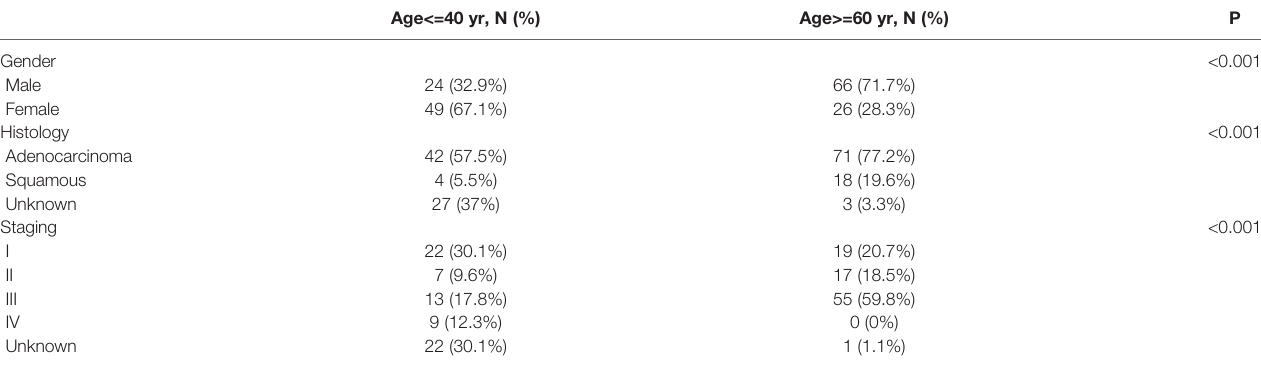
TABLE 1 | Clinical information of the cohort with 165 lung cancer